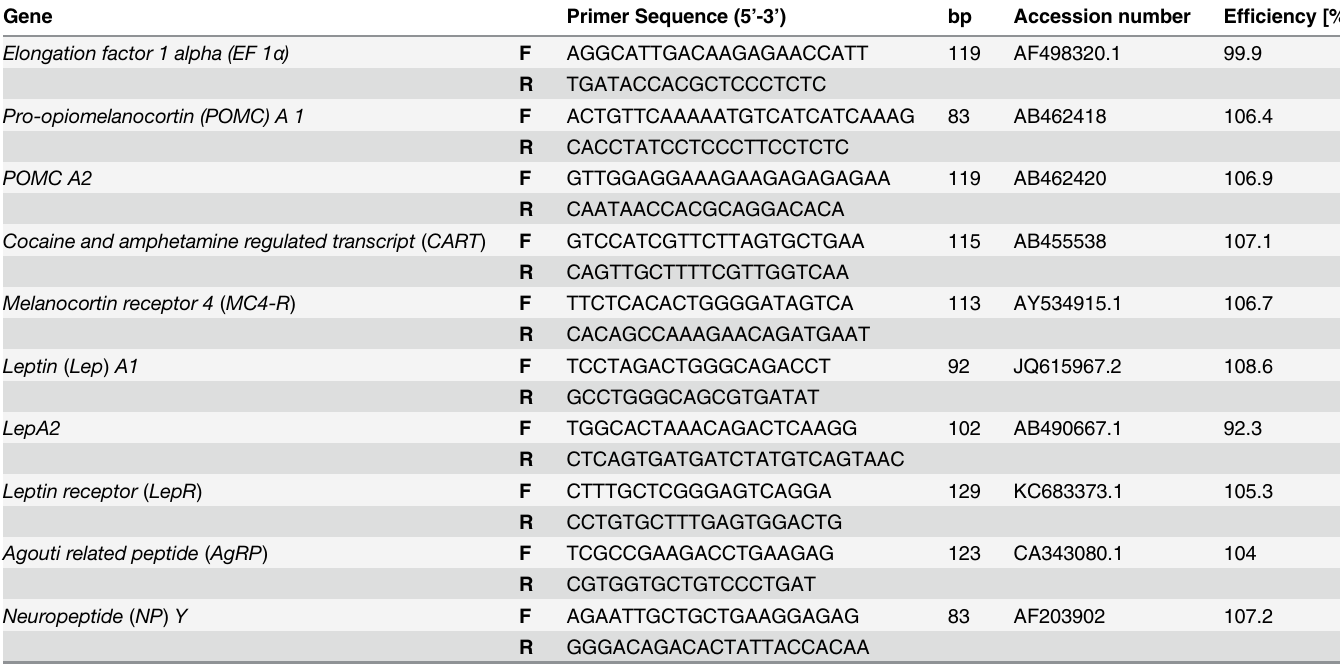
Table 2. Forward (F) and reverse (R) primer sequences used for cDNA amplification by qPCR. Gene Primer Sequence (5 ’ -3 ’